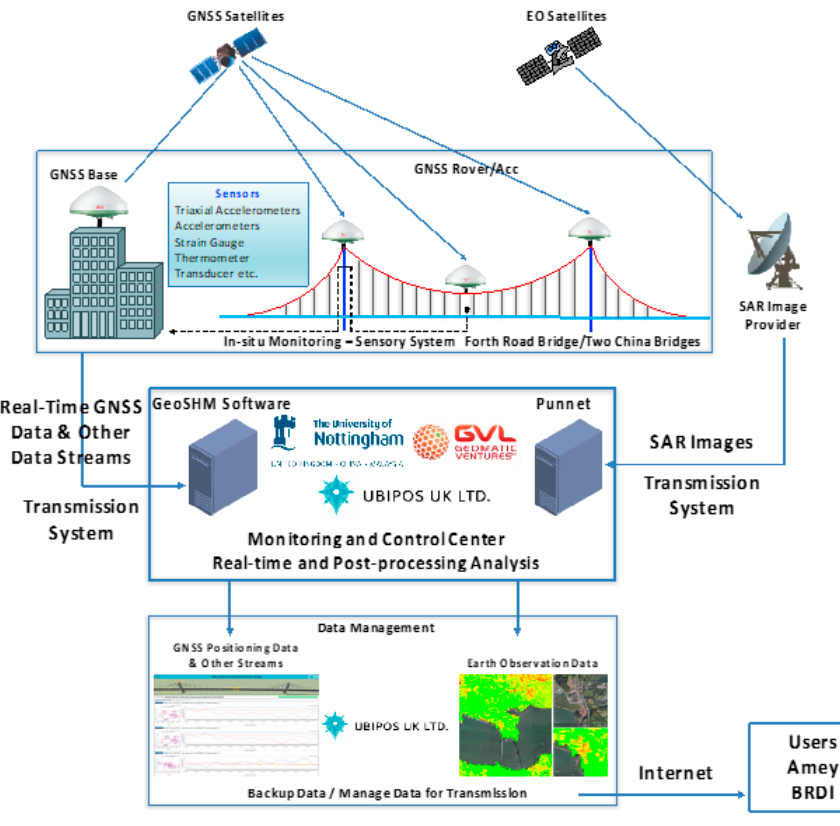
Figure 1. Layout of the GeoSHM system.